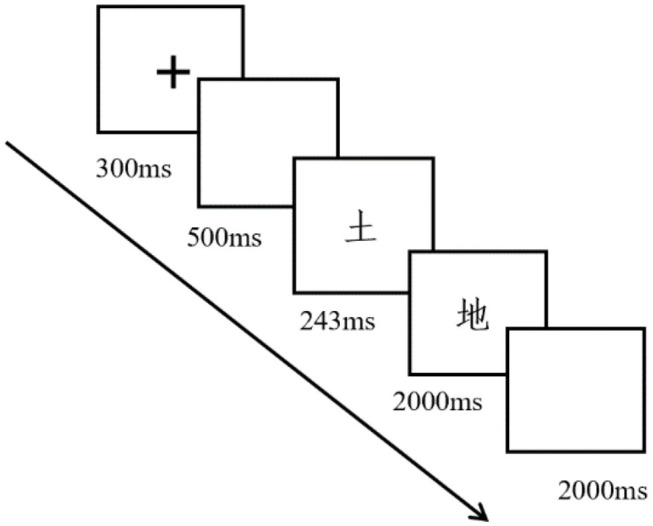
The experimental procedure.